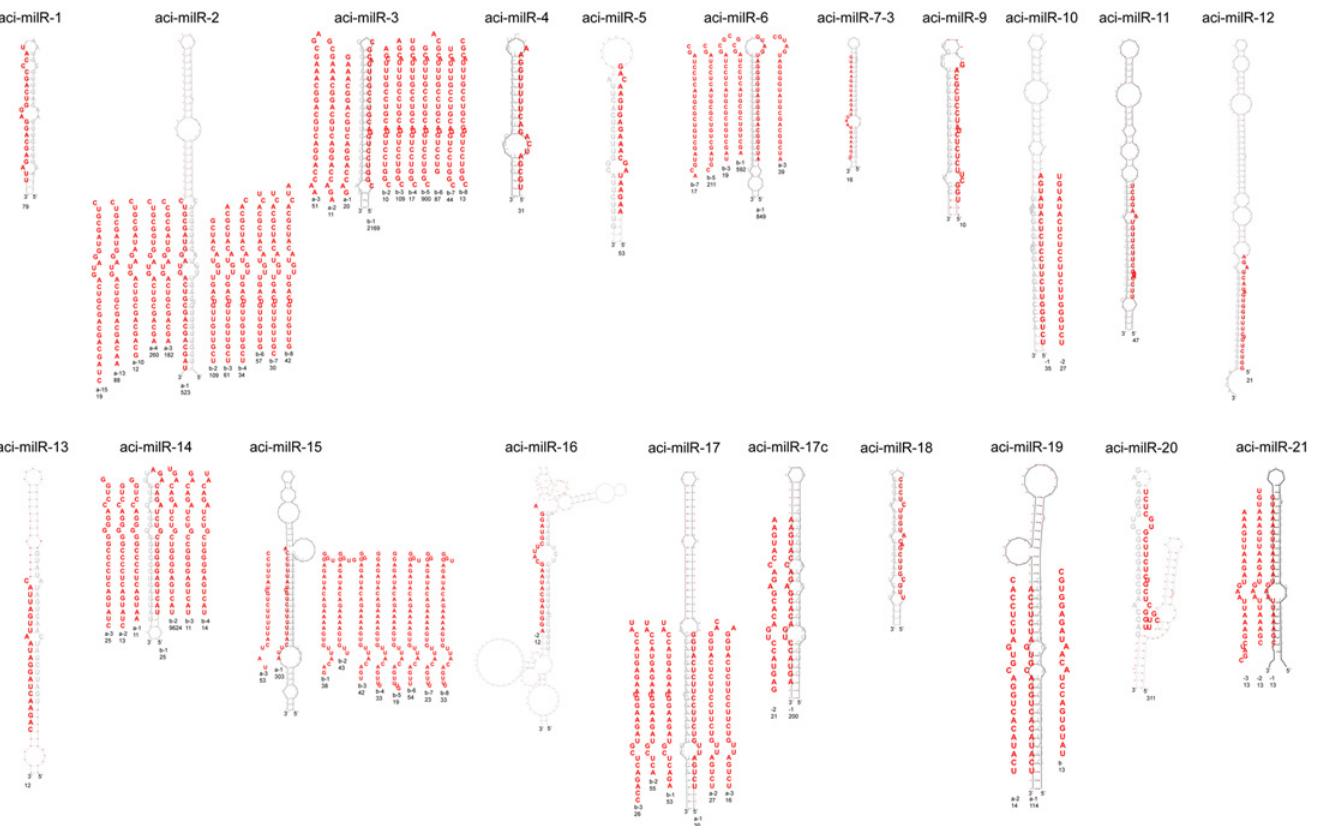
Fig 4. Secondary hairpin structures of milRNA from A . cinnamomea predicted by RNAfold. The milRNAs were sorted by the source of the precursors. milRNAs are marked in bold red and the reads are listed below.